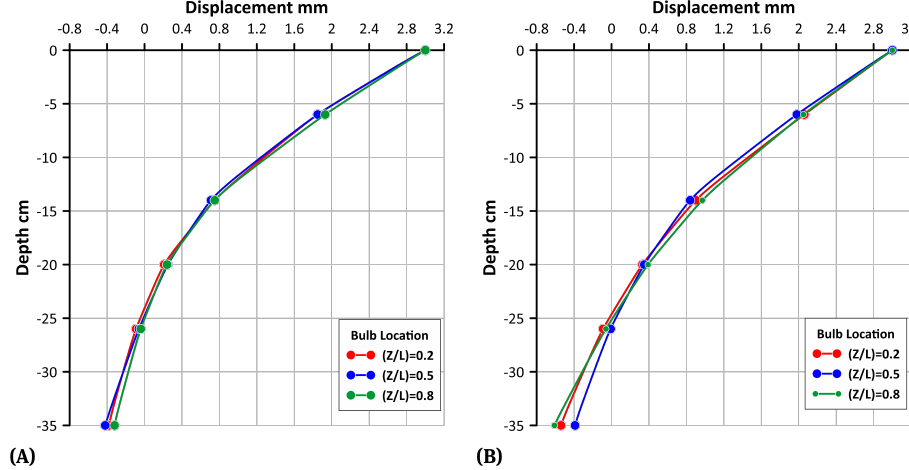
Figure 10: Lateral displacement along with the under-reamed piles under lateral (A) Unsaturated soil (B) Saturated